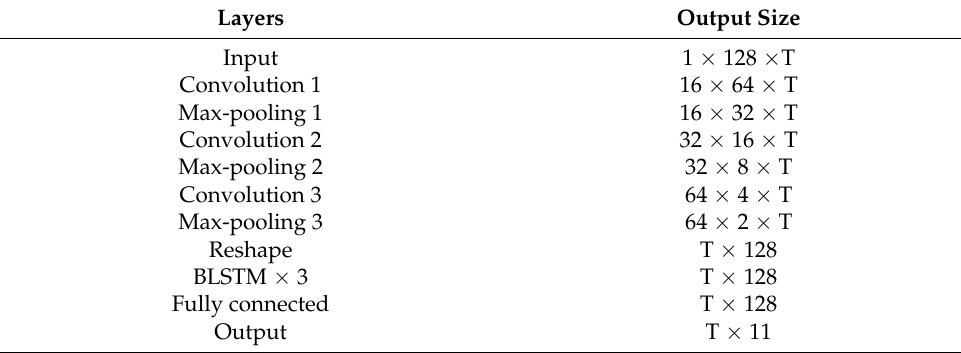
Table 2. Configuration of